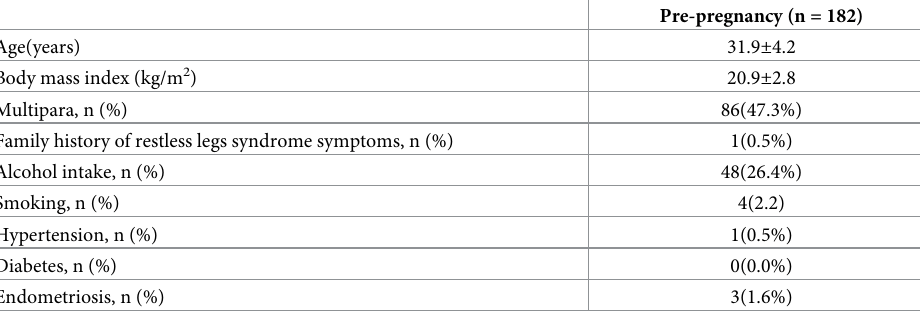
Table 1. Pre-pregnancy